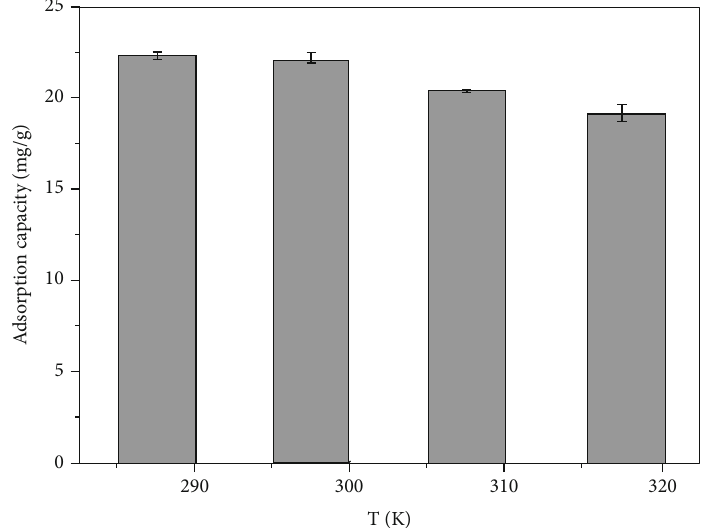
Figure 6: E ff ect of temperature on Cr (VI) removal of CSBT. (Absorbent dosaging, 400mg/L; initial concentration, 10mg/L; pH value, 3.0; contact time, 90min; rpm,